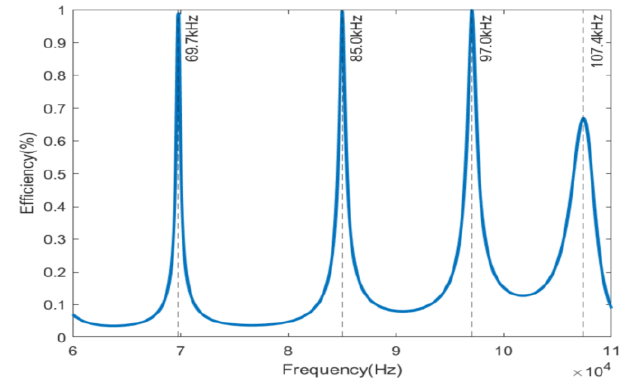
Figure 10. Frequency response of LCC-LCC topology.